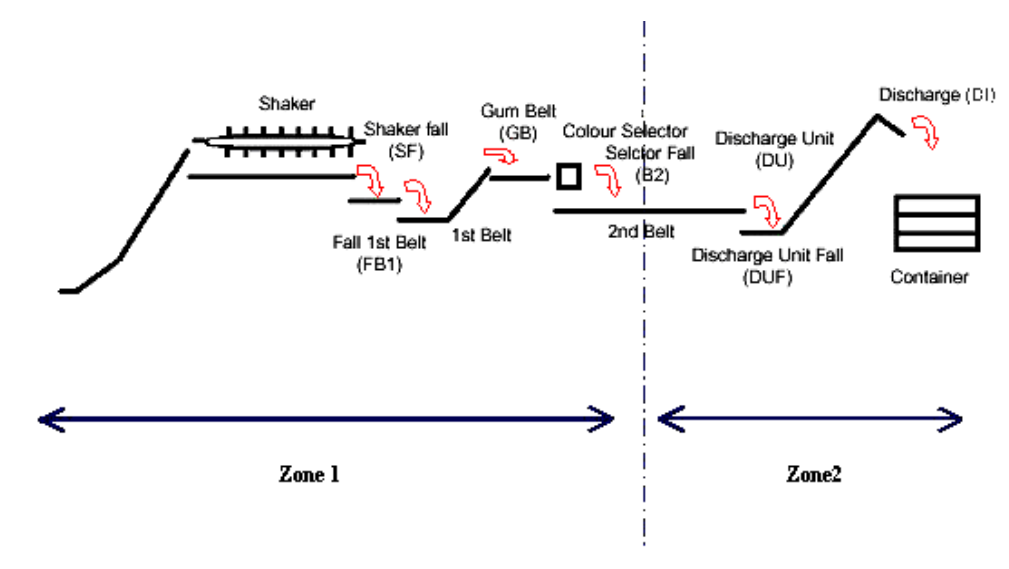
Figure 3. Harvester scheme: elements and zone